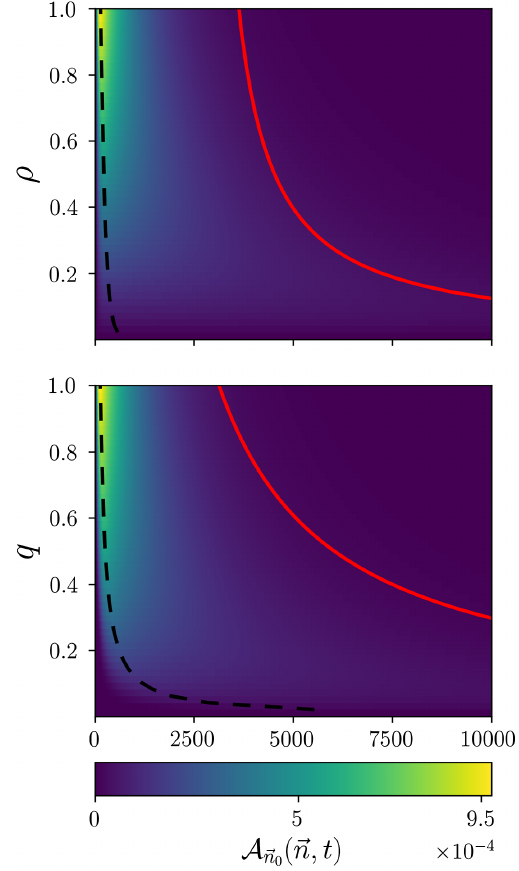
⃗ n; t Þ in a 2D FIG. 5. Plot of the absorption probability A ⃗ n 0 ð periodic domain of size 30 × 30 as a function of time obtained from a numerical z inversion of Eq. (28) with the walker having ⃗ n; z Þ . The partially absorbing target is q 1 ¼ q 2 ¼ q in ˜ P ⃗ n 0 ð located at ⃗ n ¼ ð 21 ; 9 Þ , and the initial condition is at site ⃗ n 4 ; 18 Þ . The top panel is drawn for absorption values in 0 ¼ ð the range 0 . 001 ≤ ρ ≤ 1 and q ¼ 0 . 8 , while the bottom panel is drawn for 0 . 001 ≤ q ≤ 1 and ρ ¼ 0 . 8 . The solid line is the mean of the distributions, while the dashed line represents the